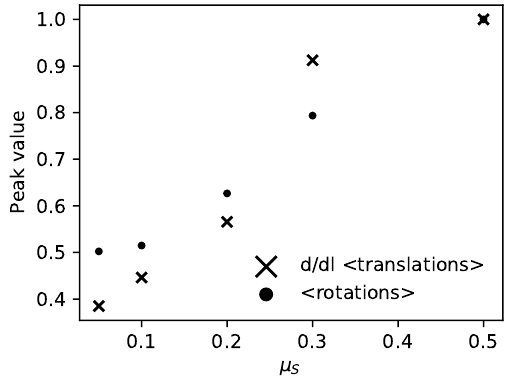
Figure 6. Peak value of the derivative of the translations (crosses) and the rotations (circles) as a function of friction. Data points were normalized by the highest peak value for compari-